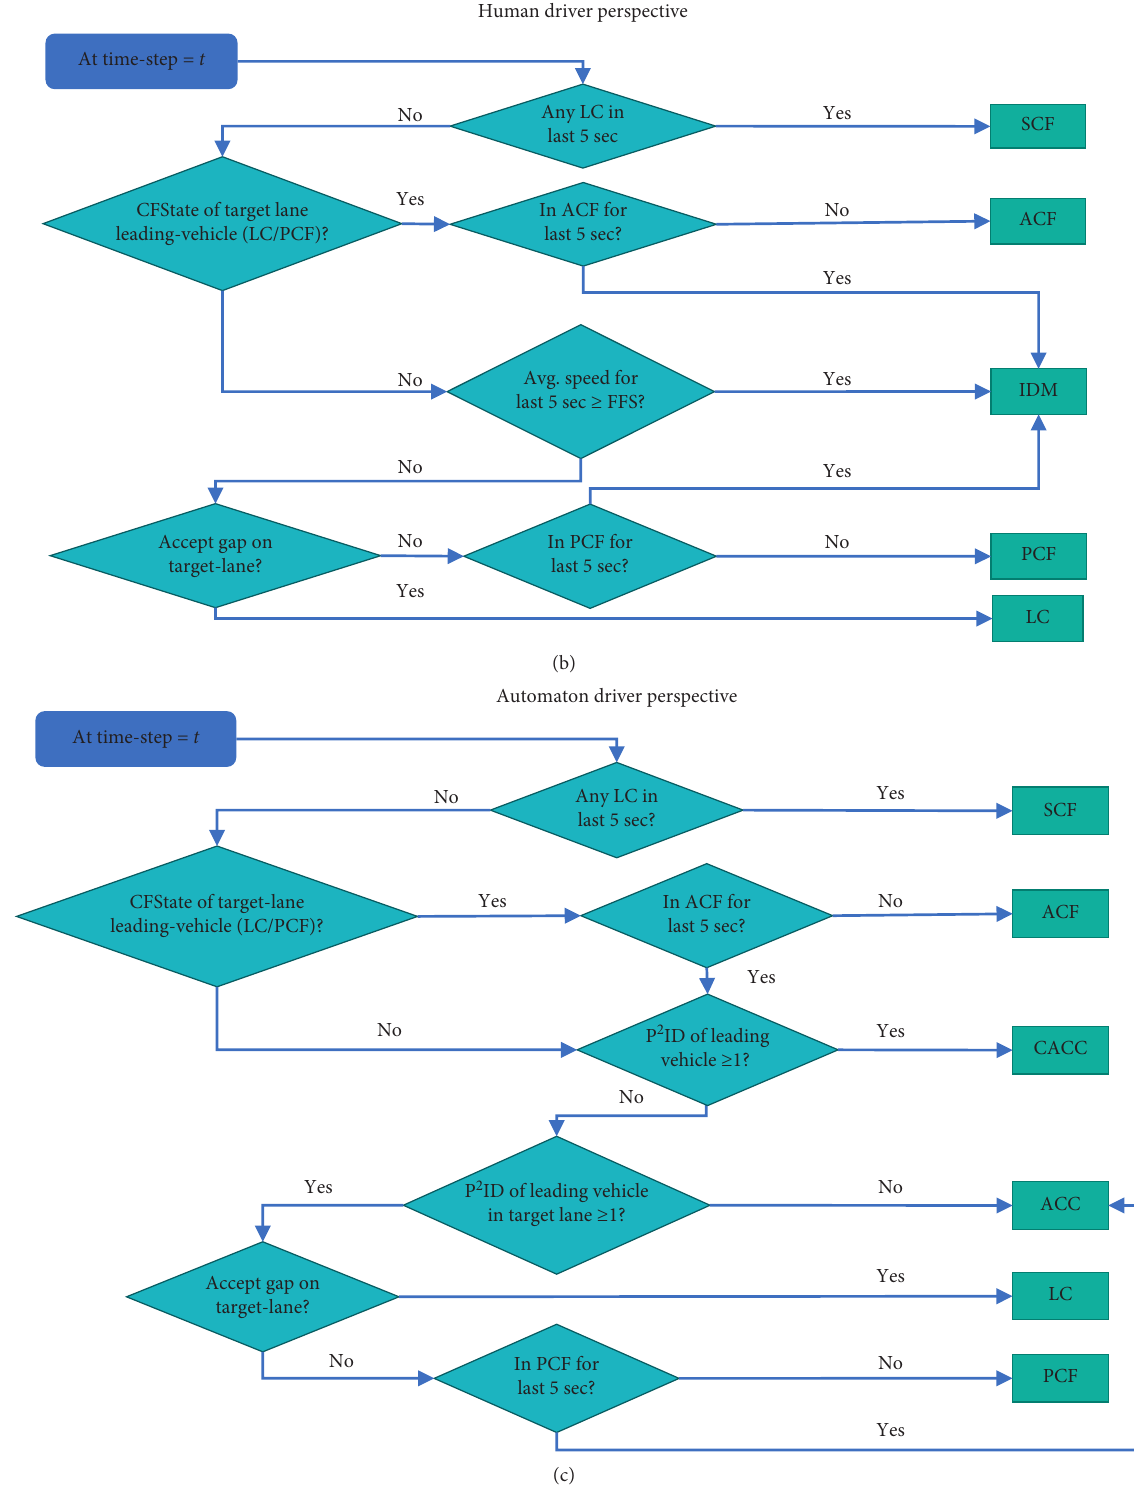
Figure 1: (a) Implemented formulae for the modeling framework, (b) principles for a human driver, and (c) principles for an automaton driver to model multilane traffic